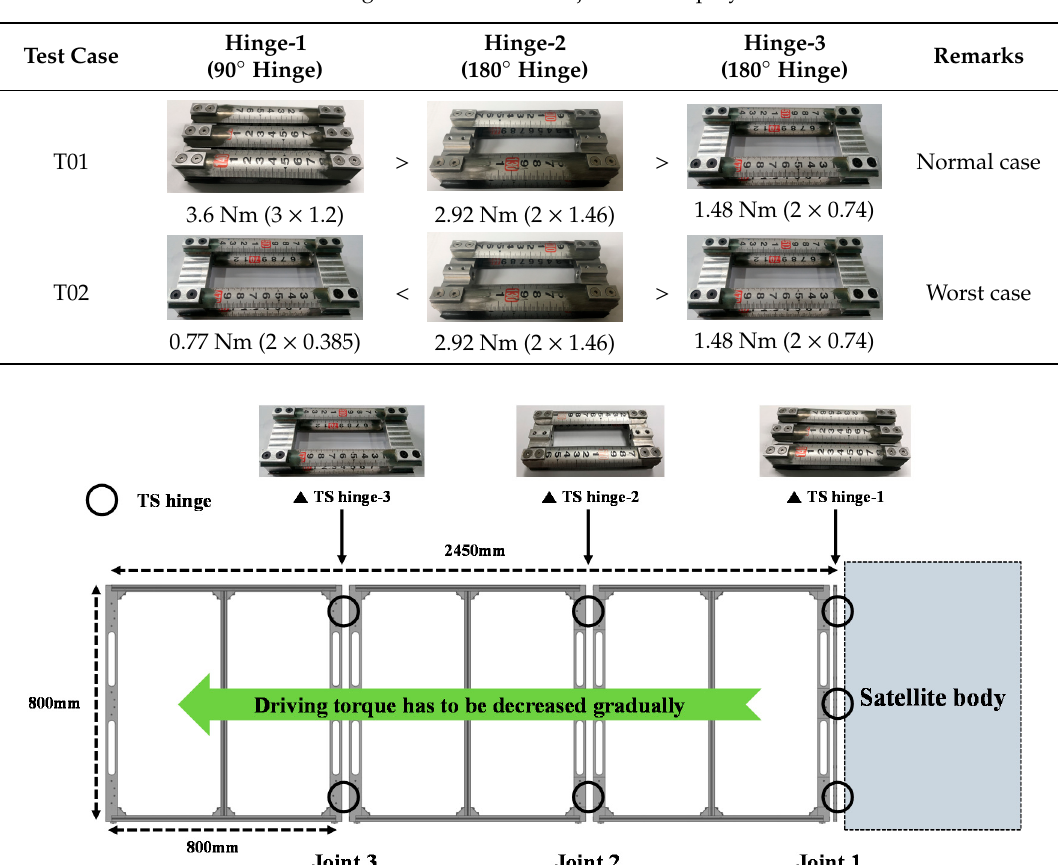
Figure 7. Configuration of dummy open solar panels and hinges with three revolute joints for test case T01.